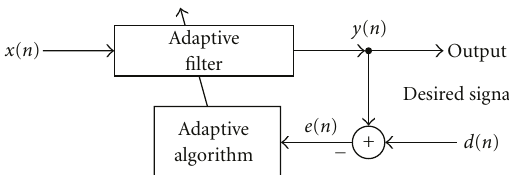
Figure 6: General adaptive filter configuration.